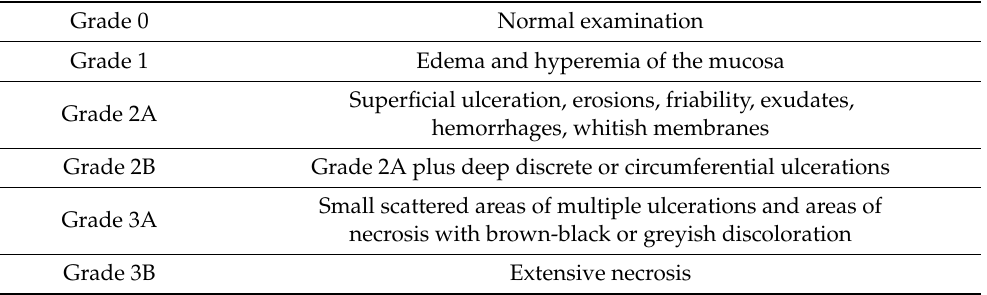
Table 1. Modified Zargar’s endoscopic classification scale [6,9,12].